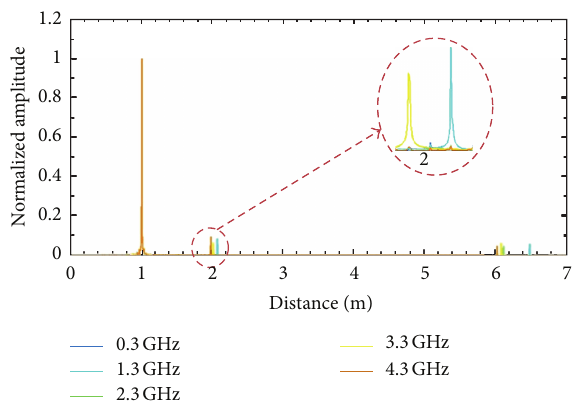
Figure 9: Shift effect on the retrieved signal